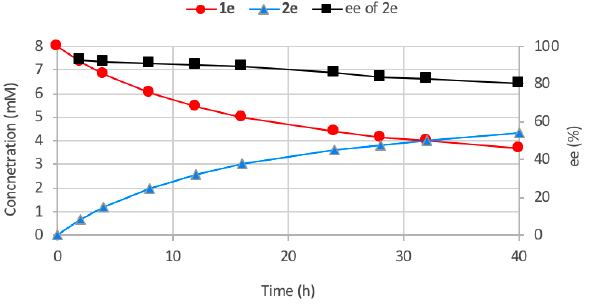
Figure 2. Preparative kinetic resolution of 1e. Conditions. [S] = 8 mM, [PLE] = 5.0 mg/mL, [ β -CDX] = 10 mM in phosphate buffer (100 mM) and DMSO (8%) at pH = 7.0, 25 °C.